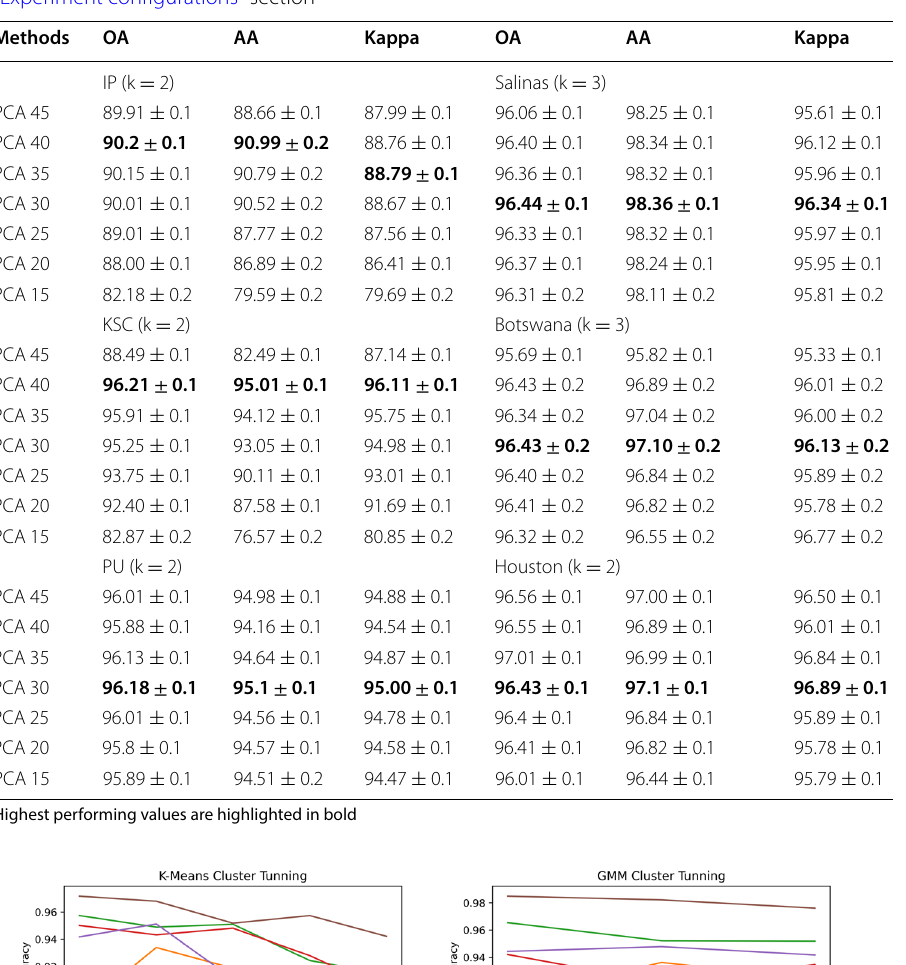
Table 4 Experimental results exploring the favorable feature size without patching for each dataset using the spectral feature reduction method PCA. An explanation of the metrics can be found in "Experiment configurations" section